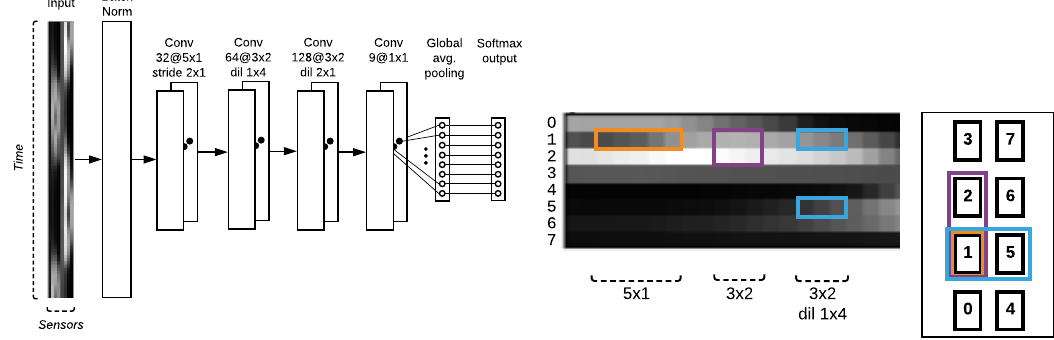
Figure 8. The three different kernel structures are used to extract different sensor correlations. Along the x-axis, features are extracted across time, and along the y-axis neighboring sensors are combined. These filters are the fundamental building blocks of a convolutional neural network. On the left, the sequential convolutional neural network (CNN) structure is shown with the classification layer on top.